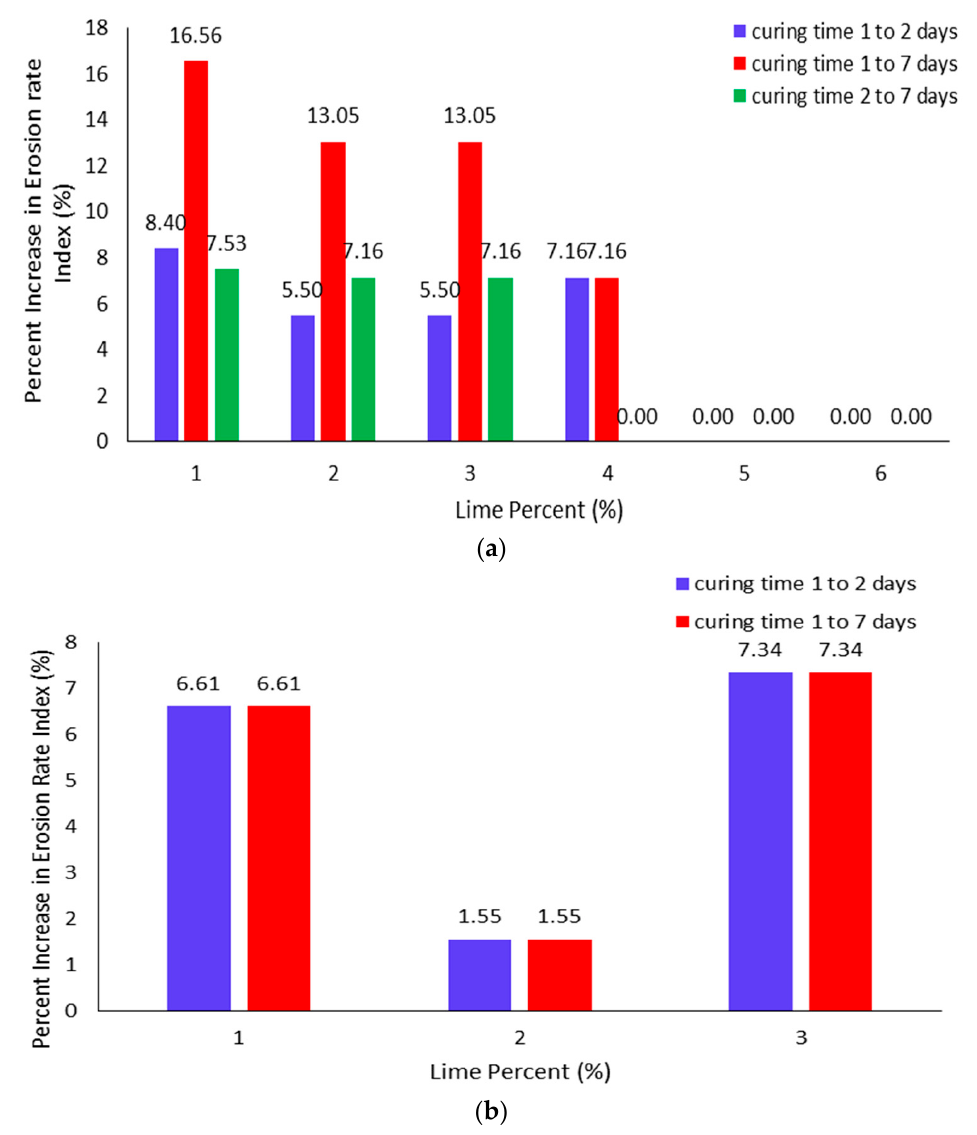
Figure 7. Percent increase in erosion rate index (%) due to the increase in curing times for different lime percentages in ( a ) Soil #1 and ( b ) Soil #2.